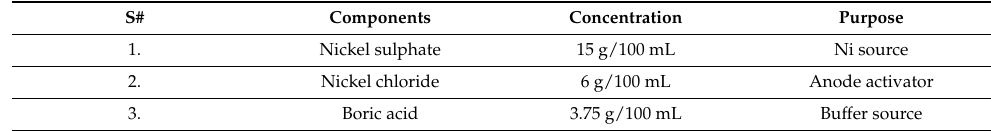
Table 2. The sulphate bath composition for nickel electrodeposition.